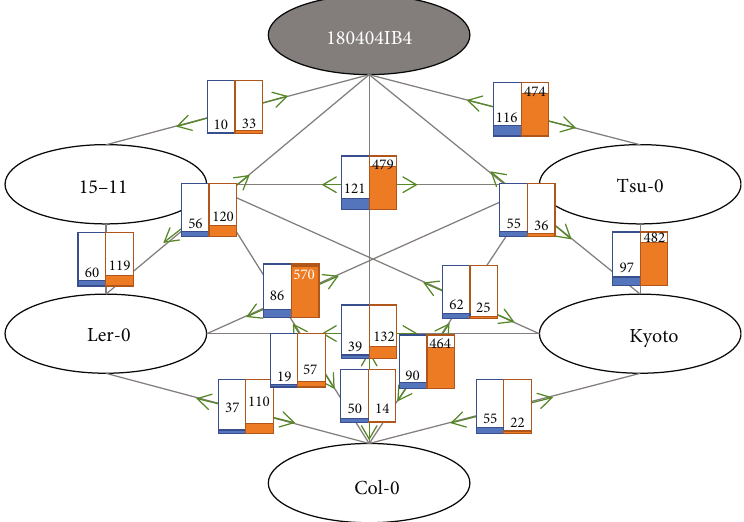
Figure 2: Sequence variation map of six Arabidopsis thaliana chloroplast genomes. Eclipses with black border indicate six isolates of A. thaliana and blue and orange bar graphs on grey lines connected between two eclipses indicate the numbers of SNPs and INDELs between two isolates. Green thick arrows show two isolates related to the numbers of SNPs and INDELs. of INDELs